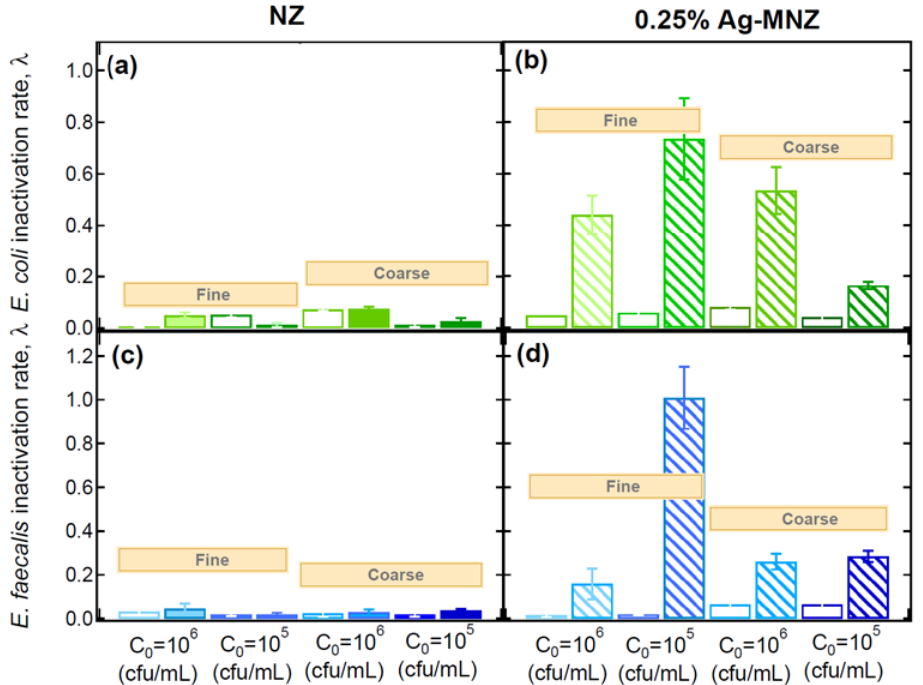
Figure 4. Estimated inactivation rates, λ , for E. coli ( a , b ) and E. faecalis ( c , d ) for the two initial bacteria concentrations: in the presence of NZ ( a , c ) and Ag-MNZ ( b , d ), in controls (empty columns) and reactors (filled and cross-shaded columns, respectively). Table 1. Fitted inactivation parameter values ( , , and ) of E. coli and E. faecalis for the two initial concentrations (10 6 and 10 5 cfu/mL) under experimental conditions.